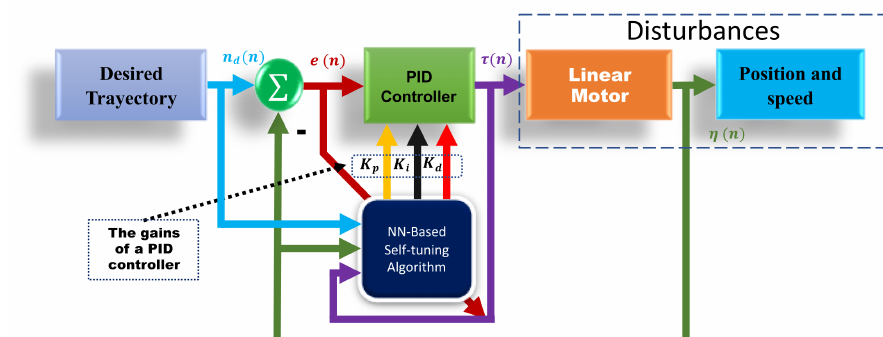
Figure 5. PID controller auto-tuning diagram.